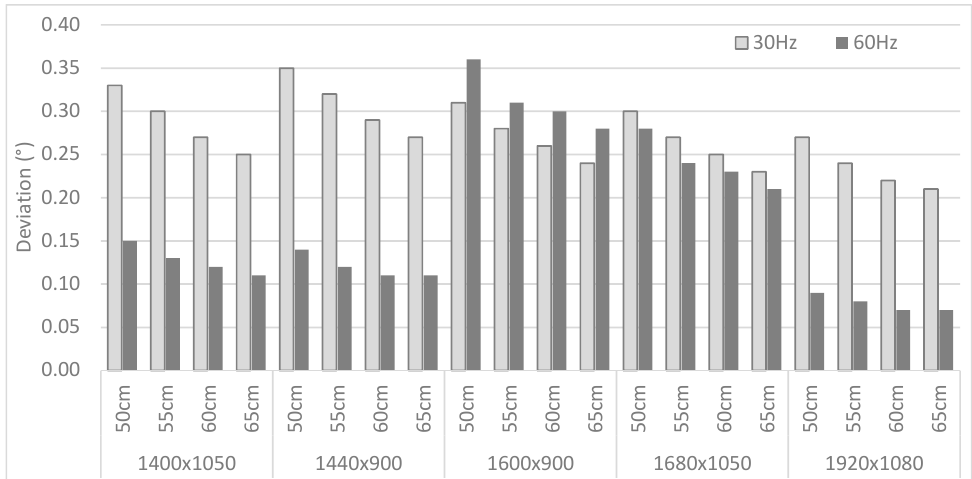
Figure 6. Deviations (visual angle) for the AP computed for all distances and all available resolutions for M1, for both 30 Hz and 60 Hz set-ups.